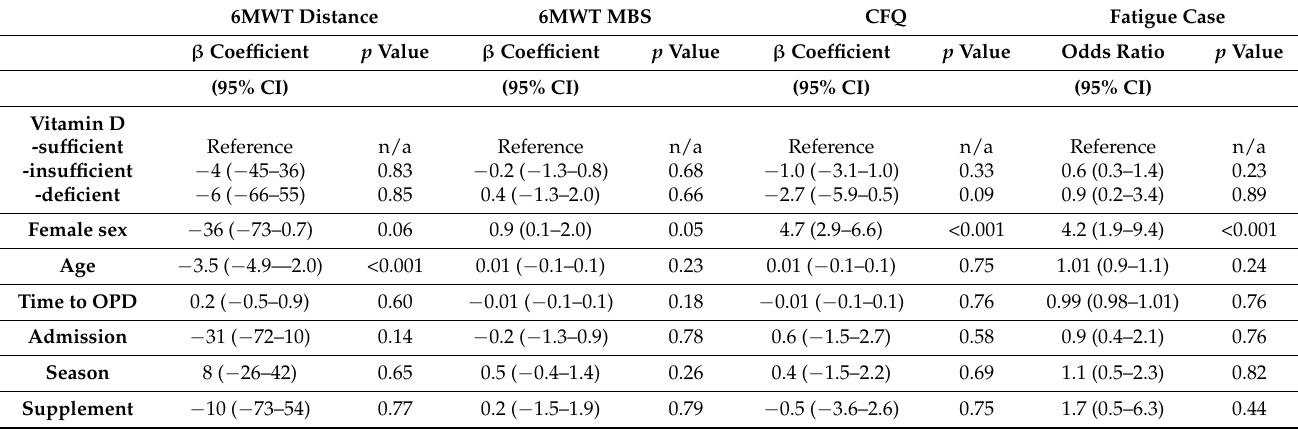
Table 3. Multivariable regression analysis of relationship between vitamin D sufficiency and physical health